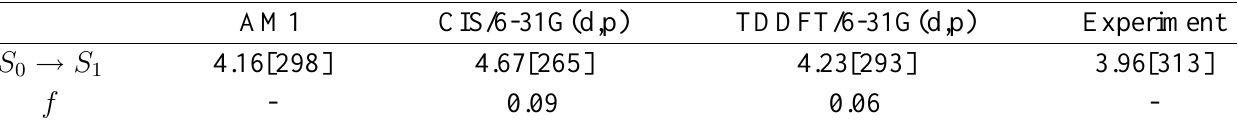
Table 1. Transition energies in eV [nm] and oscillator strengths at ground state geometry ( S energies were scaled by a factor of